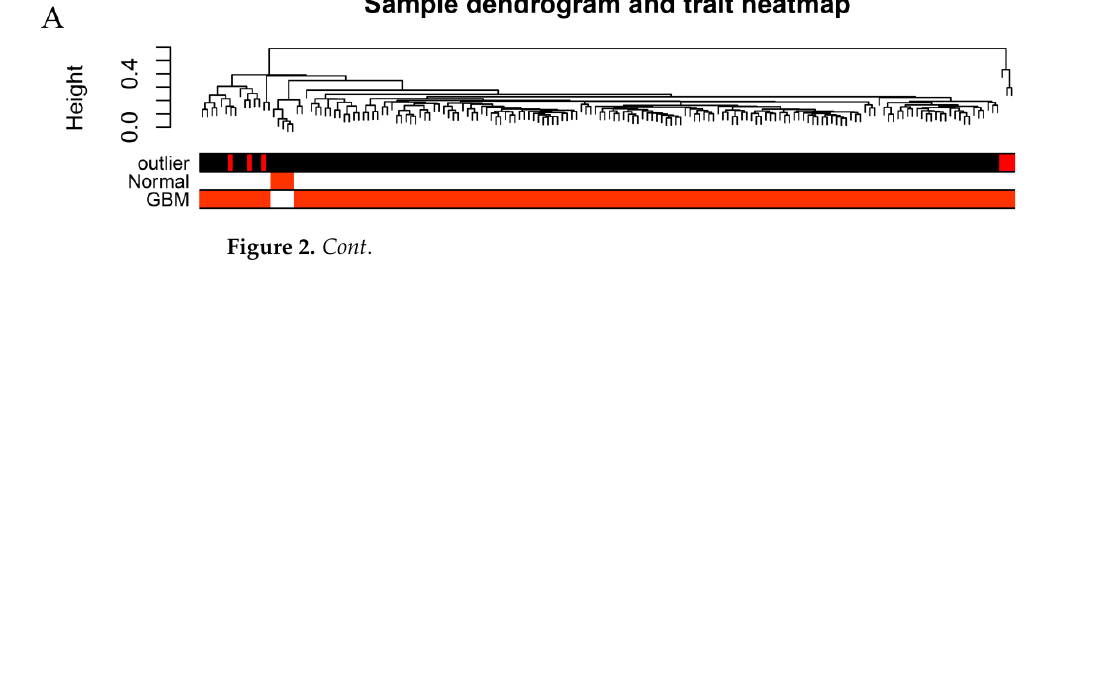
Figure 2. Associated module connected to clinical characteristic recognition. ( A ) Trait heatmap and sample dendrogram. Color intensity indicates patient condition. ( B ) Scale-free fit index analysis of soft-thresholding powers ( β ); mean connectivity index analysis of soft-thresholding powers; histo- gram of frequency distribution when β = 3; check scale-free topology when β = 3. ( C ) Dendrogram of clusters of differentially expressed genes based on dissimilarity measure (1-TOM). ( D ) Heatmap showing relationship between module eigengenes and ccRCC clinical data. ( E – H ) Scatter diagrams of gene module membership correlation in blue, black, turquoise, and purple modules with gene significance. ( I ) Average gene significance distribution in modules linked to GBM illness status. ( J ) Network heatmap plot for all genes in WGCNA. ( K ) Traditional MDS plot with TOM dissimilarity as its input. Module assigns color for each gene-designated dot.